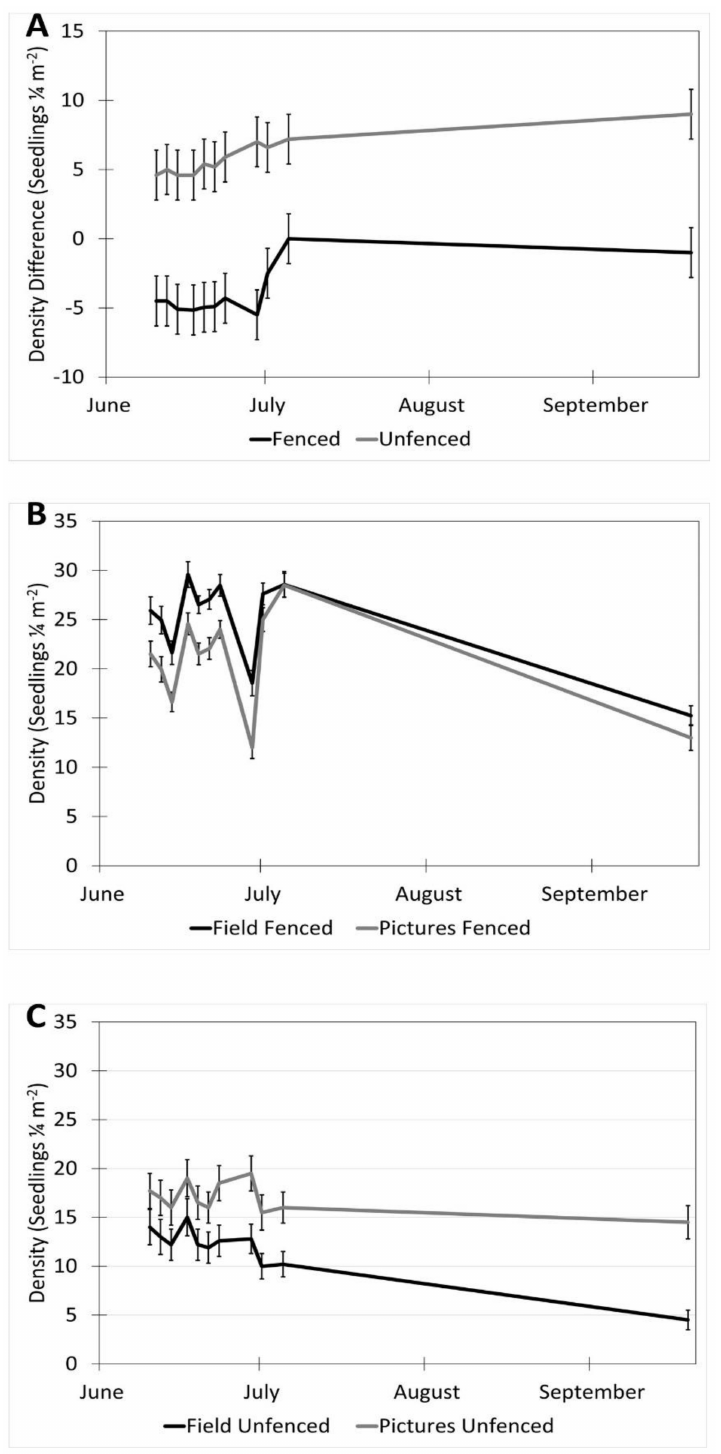
Figure 9. Interaction of date and fencing for density estimates in images vs. field (estimates ± SE). ( A ) Shows the difference in density for fenced vs. unfenced plots. ( B ) A comparison of image and field measurements for density in fenced plots, over time. ( C ) A comparison of image and field measurements for density in unfenced plots, over time. Data were recorded in the field every 2–3 days between 10 June and 5 July 2017, with a final sample collected on 19 September 2017 at the Utah Testing Range,